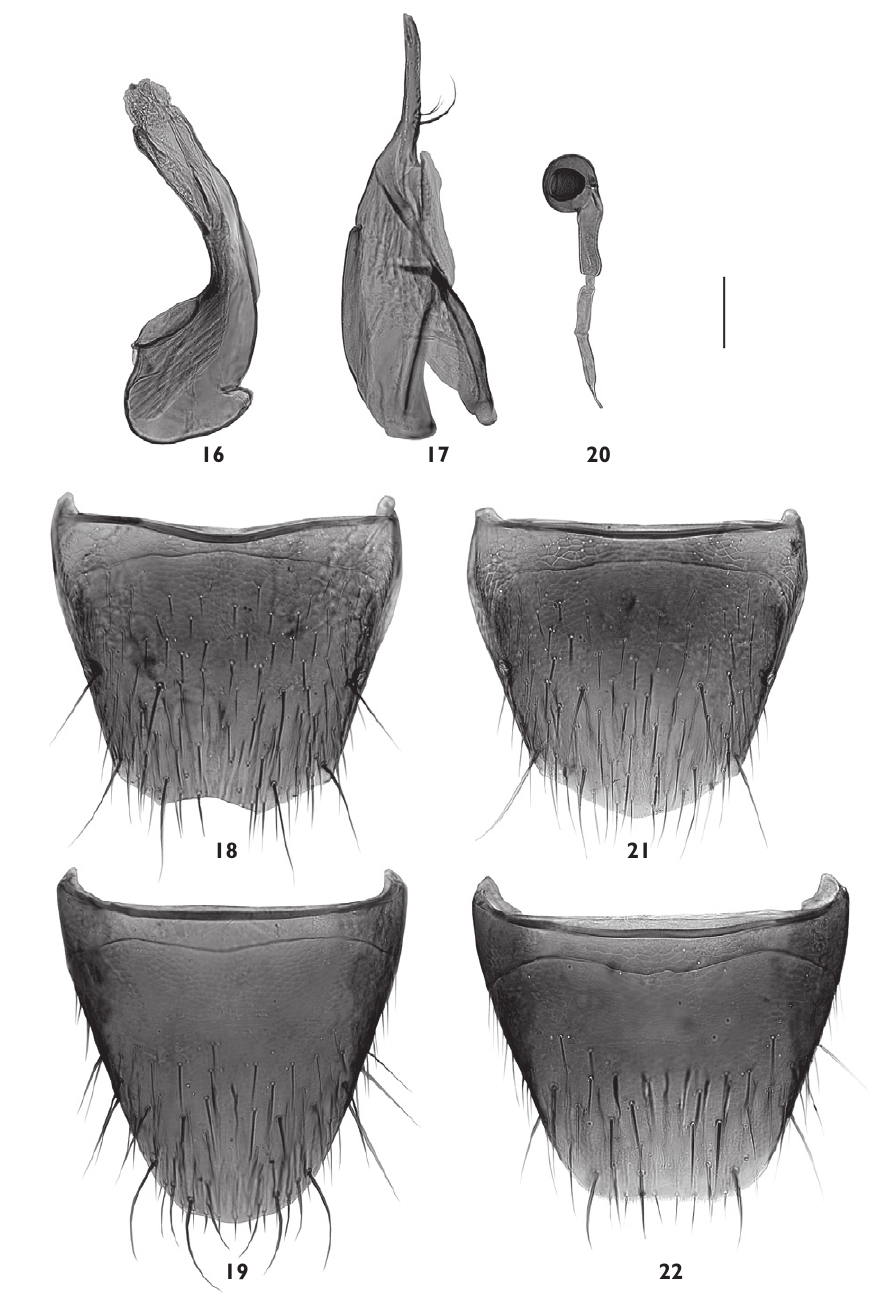
Figs. 16-22. Halobrecta fl avipes Th omson: 16, median lobe of aedeagus in lateral view (New Brunswick); 17, paramere (New Brunswick); 18, male tergite 8 (New Brunswick); 19, male sternite 8 (New Bruns- wick); 20, female tergite 8 (New Brunswick); 21, female sternite 8 (New Brunswick); 22, spermatheca (New Brunswick). Scale bar = 0.1